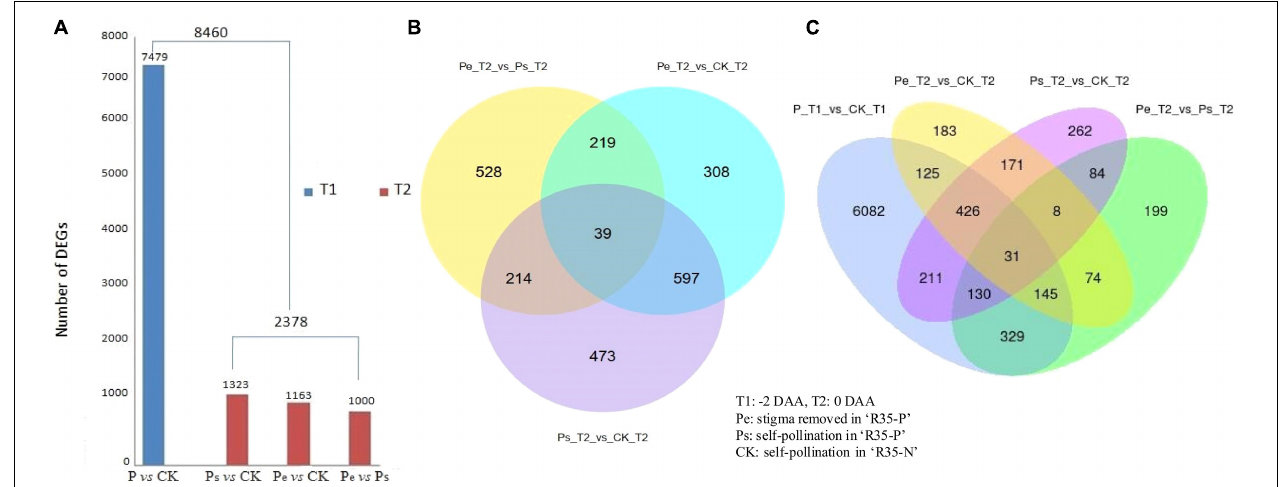
FIGURE 4 | DEGs (differentially expressed genes) of the RNA-seq data. (A) The numbers of DEGs distribution (Padj < 0.05). (B) The Venn diagrams of 2,378 DEGs at 0 days after anthesis (DAA). (C) The Venn diagrams of 8,460 DEGs at − 2 DAA and 0